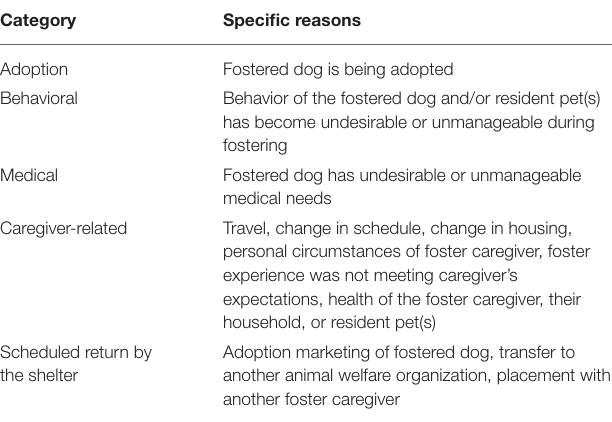
TABLE 1 | Categorization of reasons for the return of a fostered dog.